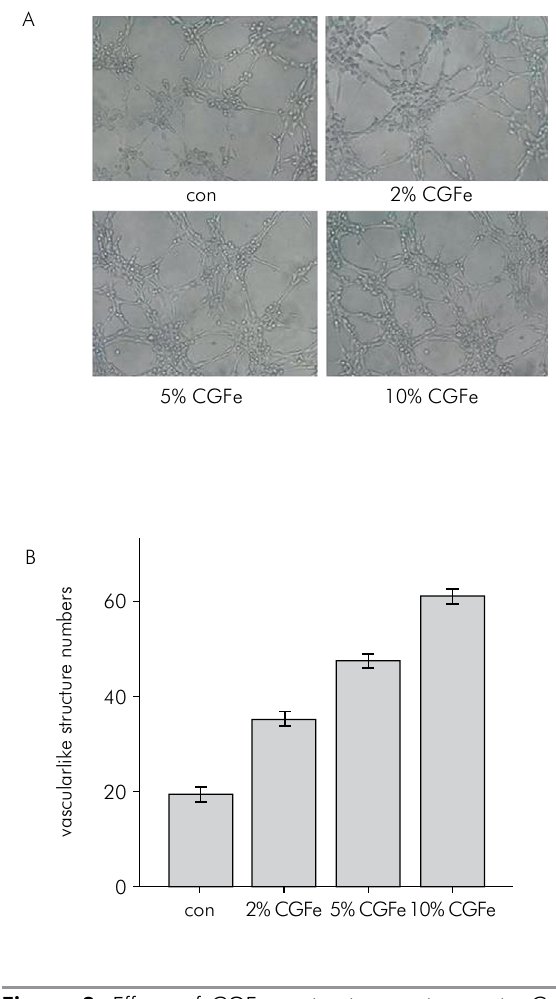
Figure 3. Effects of CGFe on in vitro angiogenesis. Cell mixtures were incubated in a matrigel-coated 96-well plate, and samples were photographed using a digital imaging system 6 h after seeding. (A) Representative images are shown above. (B) Tube numbers were quantified using Image Pro Plus 6.0. CGFe promoted vessel-like structure formation in a dose- dependent manner (p < 0.05). All data are presented as the mean ± SE of three independent experiments.